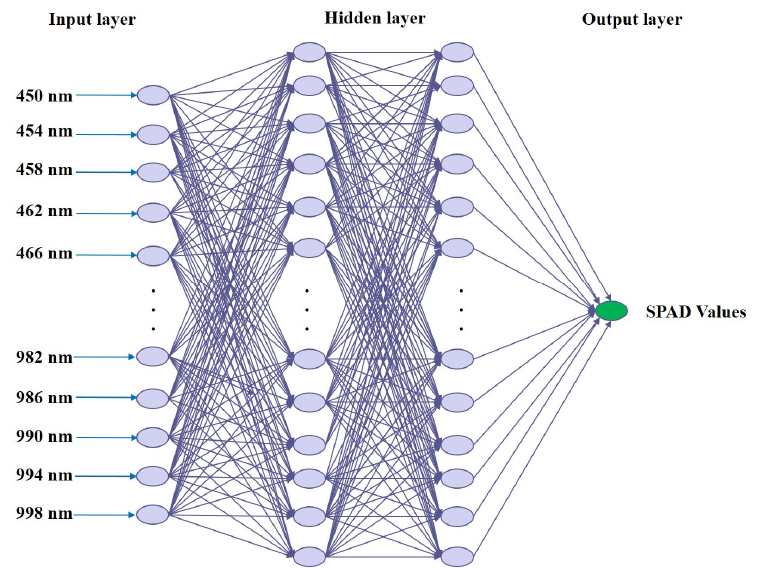
Figure 12. DNN model structure.